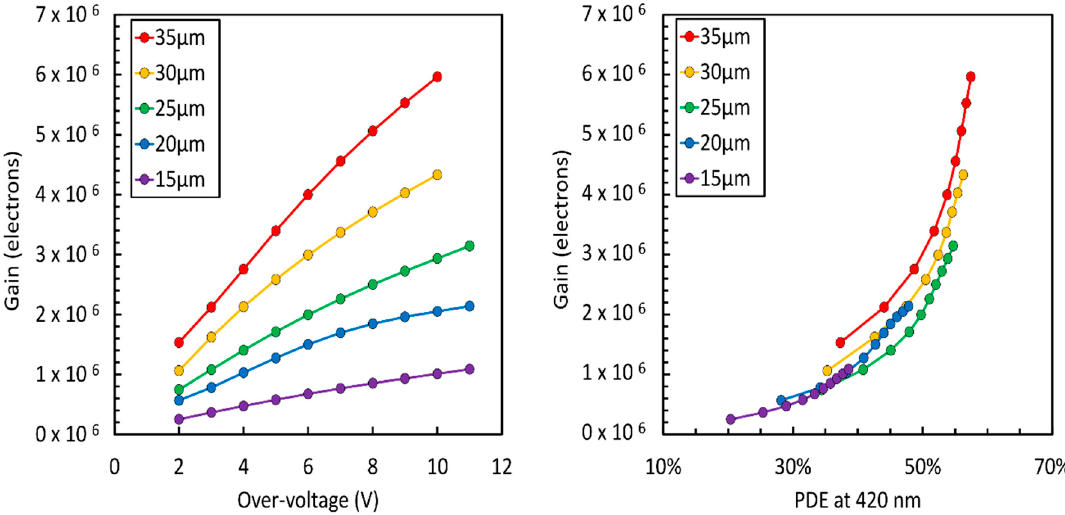
Figure 8. Left : Gain vs. overvoltage for all cell sizes. Right : Gain vs. PDE.